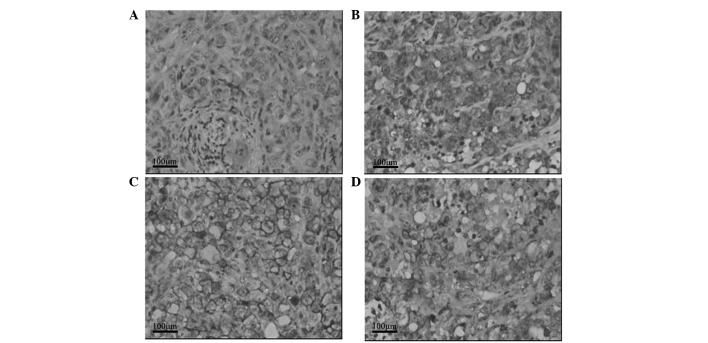
Immunohistochemical analysis of hypoxia-inducible factor-1α (HIF-1α) and major histocompatibility complex class I chain-related (MIC) expression. HIF-1α expression demonstrated in the (A) glyceryl trinitrate (GTN) and (B) placebo group. MIC expression demonstrated in the (C) GTN and (D) placebo group. Magnification, ×400.